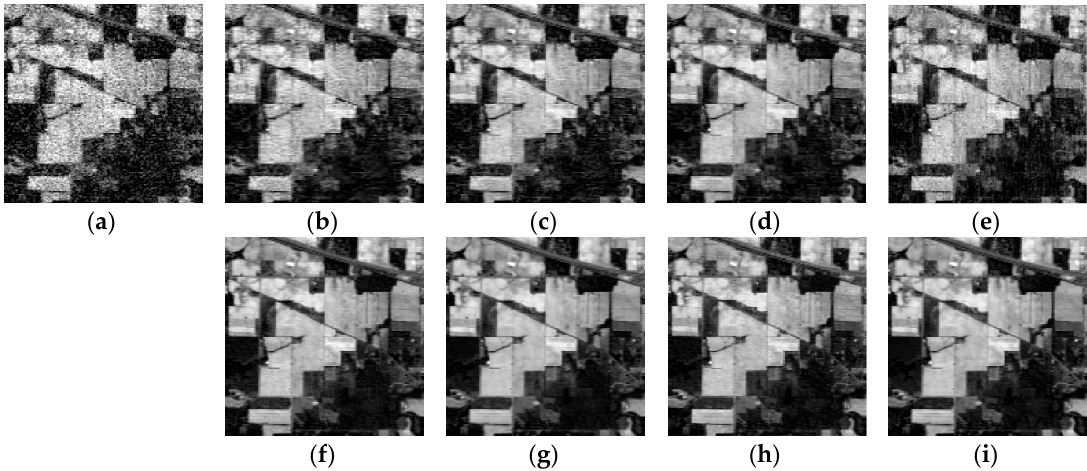
Figure 9. Denoising results for band 110 of the Indian Pine data: ( a ) Original image; ( b ) BM3D; ( c ) BM4D; ( d ) PCA + BM4D; ( e ) KSVD; ( f ) LRMR; ( g ) NAILRMA; ( h ) BPFA; and ( i ) HyDeSpDLS.